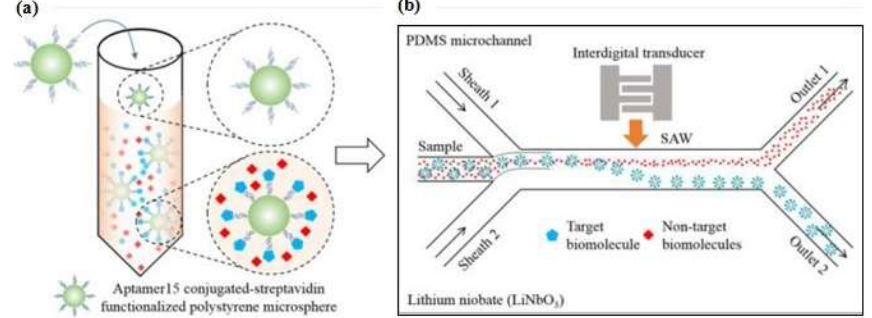
Figure 10. ( a ) Specific aptamer to form a microparticle−aptamer−target complex; the unbound particles remained in a free condition; ( b ) Separation process of the mixture solution through an acoustofluidic device. Reproduced with permission from reference [100]. Copyright 2017 American Chemical Society.